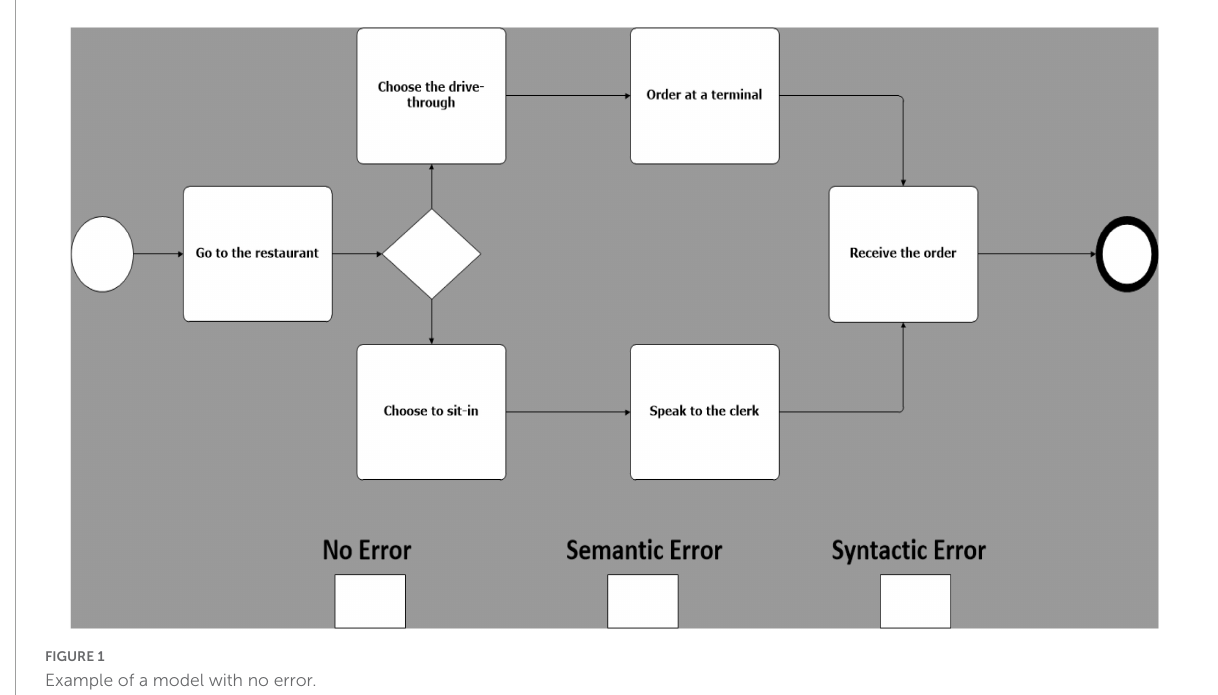
FIGURE1 Example of a model with no error.